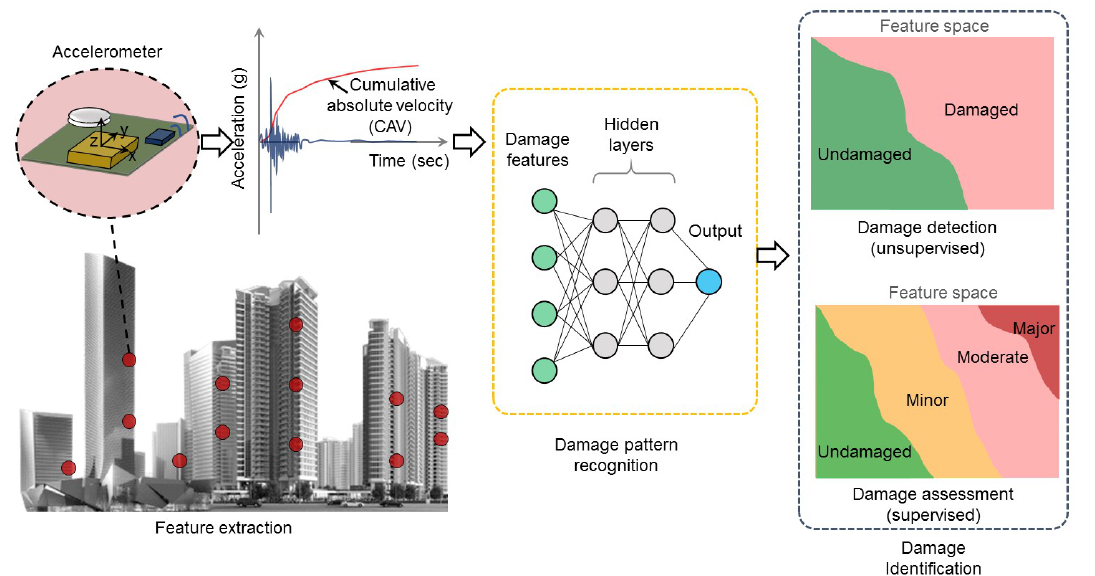
Figure 1. Proposed framework using acceleration data from instrumented structures to assess their damage conditions following an earthquake